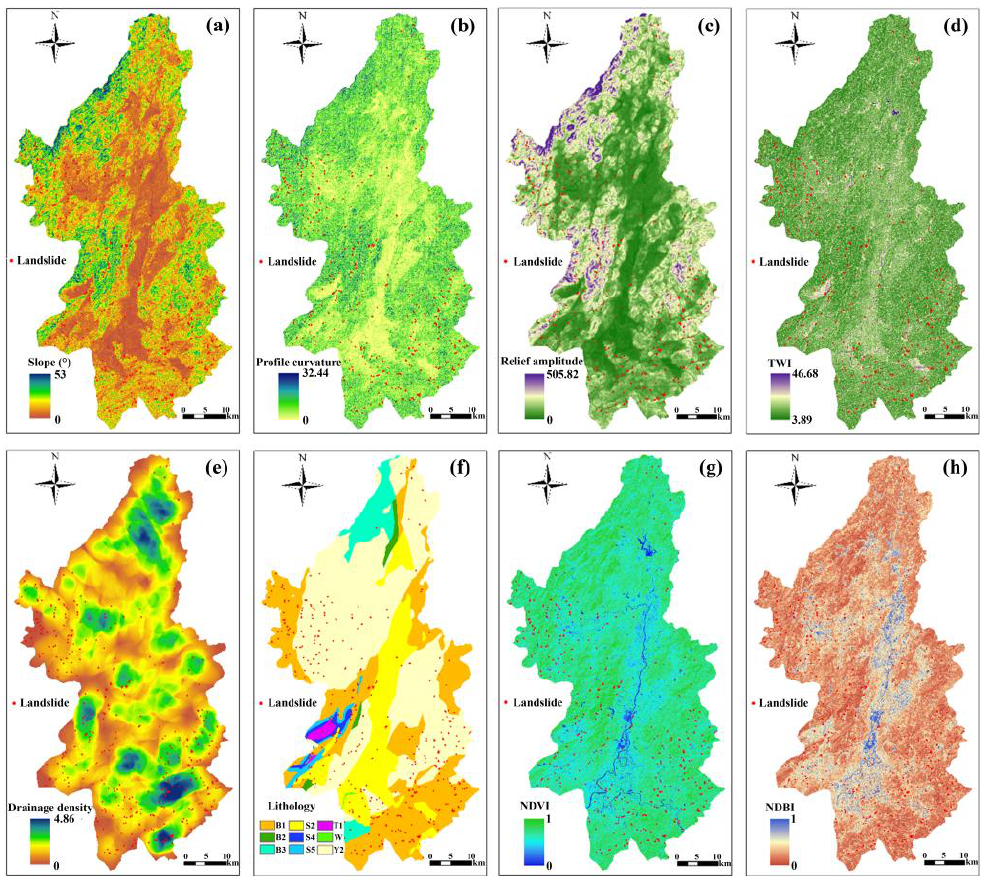
Figure 3. Landslide conditioning factors: ( a ) slope, ( b ) profile curvature, ( c ) relief amplitude, ( d ) Terrain Wetness Index (TWI), ( e ) drainage density, ( f ) lithology, ( g ) normalized difference vegetation index (NDVI), and ( h ) normalized difference built-up index (NDBI) (aspect and plane curvature are not presented).